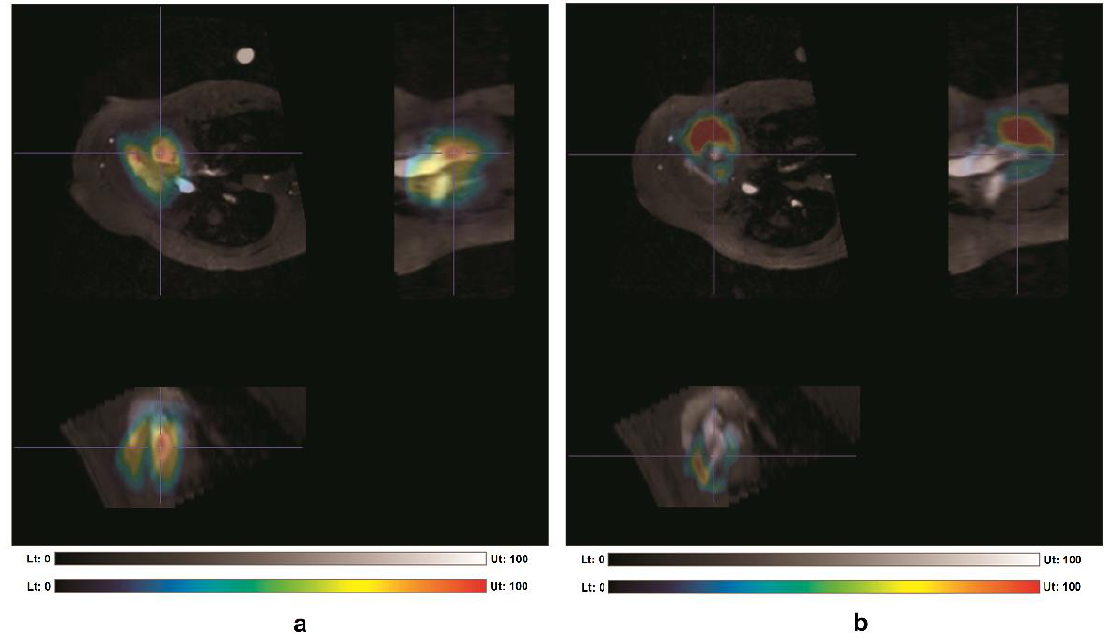
Figure 8. Hyperpolarized [1- 13 C]pyruvate and [1- 13 C]bicarbonate maps evaluated from chemical shift imaging (CSI) with the hybrid coil. ( a ) Pyruvate signal; ( b ) Bicarbonate signal. Reprinted by permission from Giovannetti et al., App Magn Reson 2013 [64].